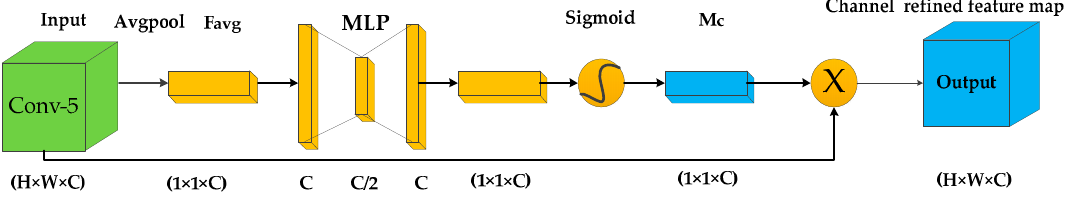
Figure 4. Diagram of the channel attention module.